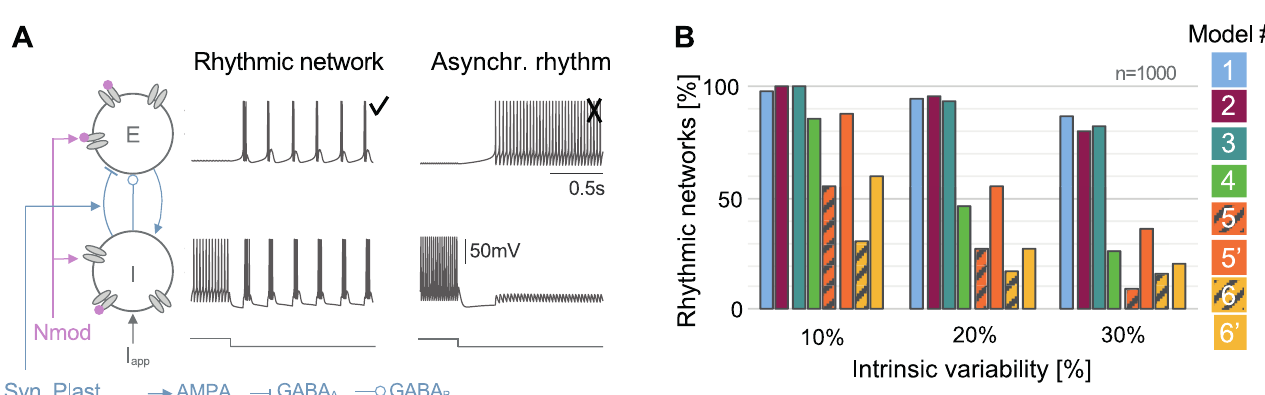
Fig 2. Slow T-type calcium channel activation ensures model compatibility with neuromodulation and synaptic plasticity at the circuit level. A : (left) Two interconnected neurons (one excitatory neuron E and one inhibitory neuron I) under the control of an external current (I app ), affected by neuromodulation (Nmod, pink spheres) and synaptic plasticity (Syn. Plast., in grayish blue). (center) The external current initially depolarizes the inhibitory cell then hyperpolarizes it leading to a switch in the circuit rhythm into a synchronous bursting. (right) Voltage traces illustrating an asynchronous rhythm, undesired behavior in the circuit. B : Percentage of rhythmic networks observed in different neuron models as intrinsic variability increases. For each model, one thousand 2-cell circuits are generated with random ionic conductances varying from 10, 20 and 30% from their nominal values -mimicking the effect of neuromodulation, and synaptic conductances, randomly picked in a uniform distribution—mimicking the effect of synaptic plasticity. Models 1 to 3 embedding a slow activation of T-type calcium channels are robust to parameter variability. Model 4 is robust at low variability than its performance is decreased due to its high number of ionic channels. Models 5 and 6 that assume an instantaneous T-type calcium channel activation are fragile: parameter variations disrupt the nominal rhythm. Replacing the instantaneous activation into a slow activation restores the robustness as shown by models 5’ and 6’ (dashed orange and yellow bars).